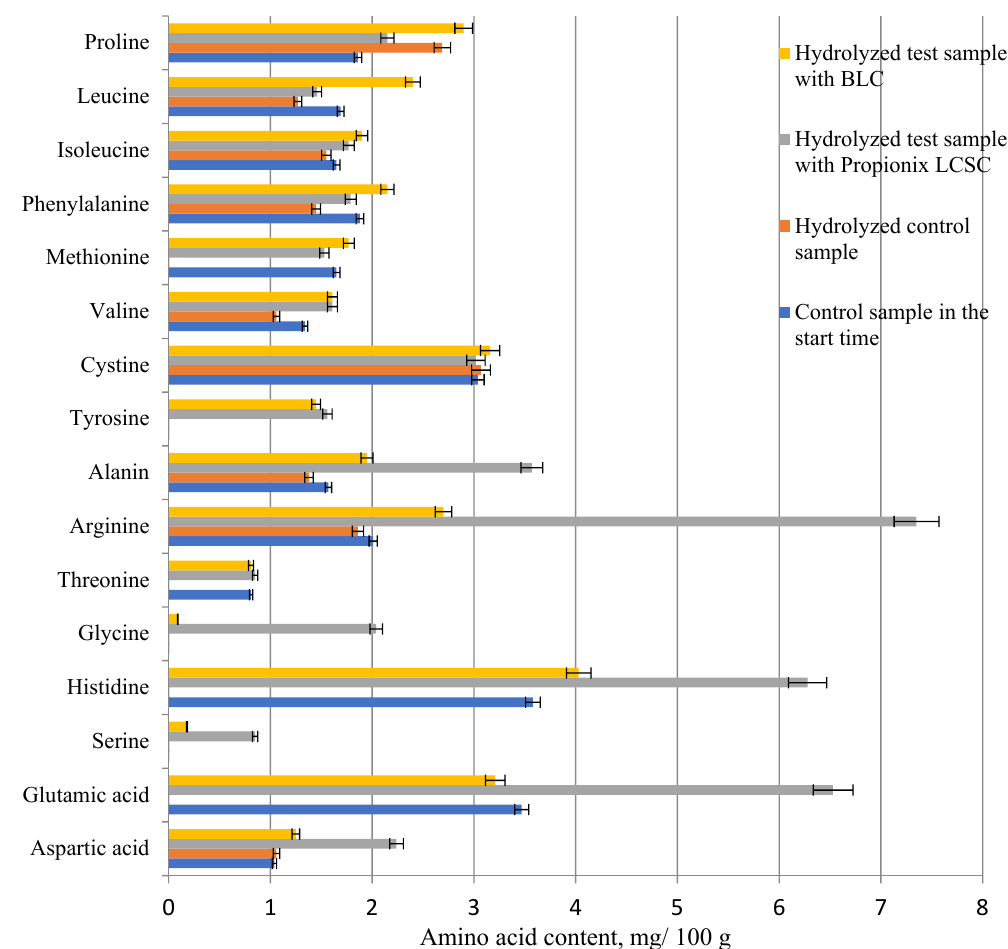
Figure 8. The results of the amino acids composition evaluation of hen combs hydrolysates (mg AA/100 g of hydrolysate).